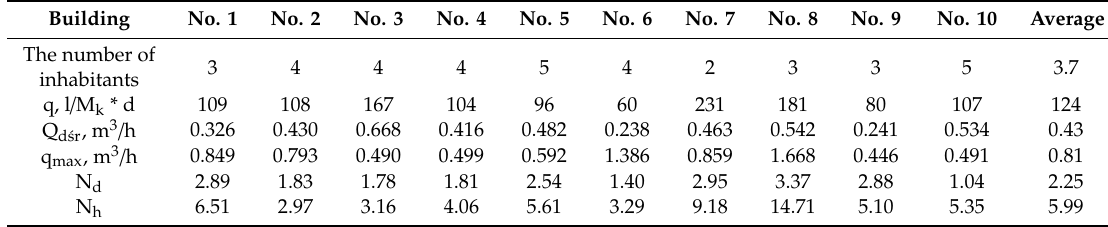
Table 4. The results obtained for single-family buildings.